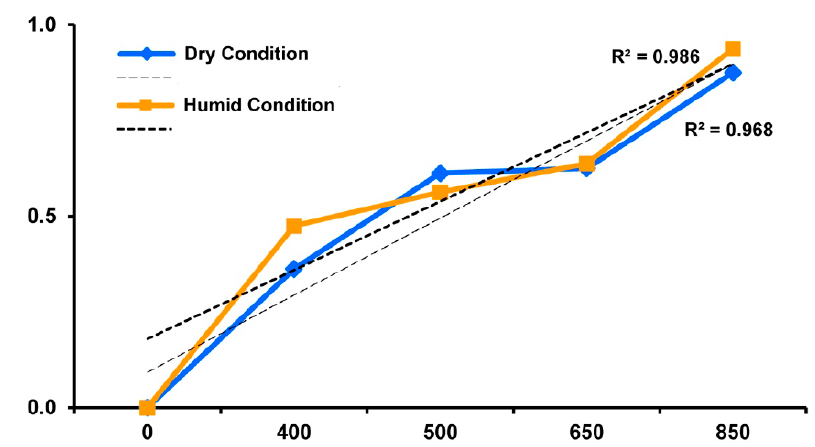
Figure 2. Correlation (R 2 ) between triclosan concentration (ppm) and the bacterial inhibition (cm) under dry and humid conditions, tested on the polyester surfaces. N = 9 for each result.